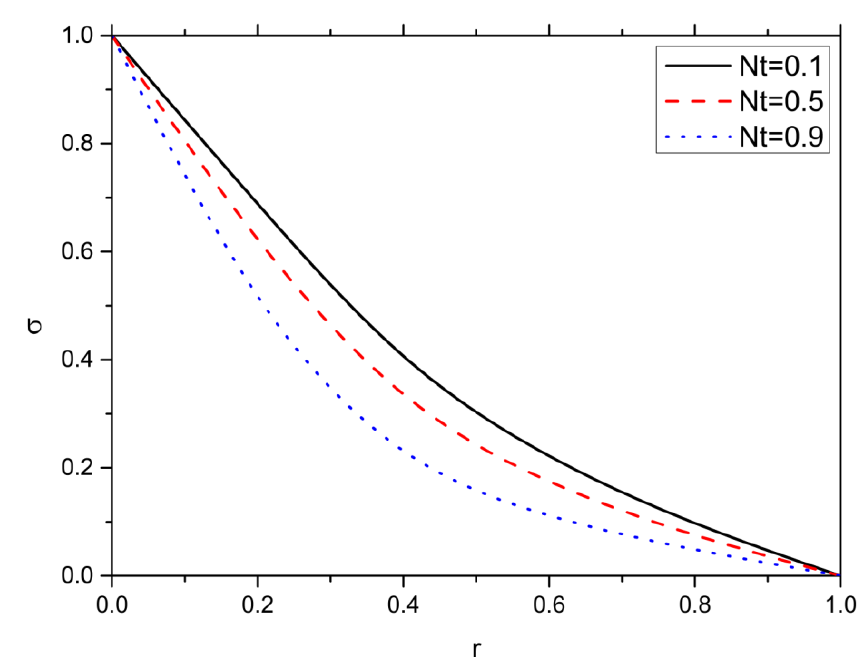
N = 0.9,  = 0.2,  =0.1, z = b